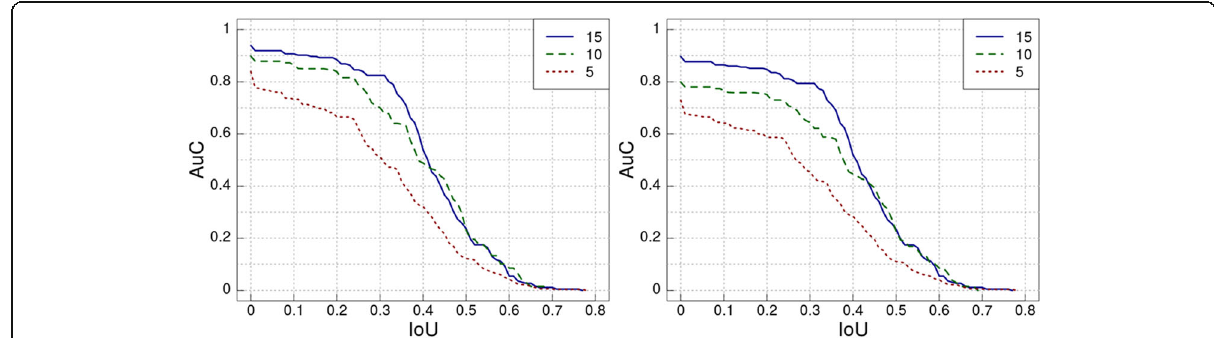
Fig. 9 Mean AuC over all interactions using four-fold cross-validation with different numbers of training sequences, for SC (left) and MC (right)